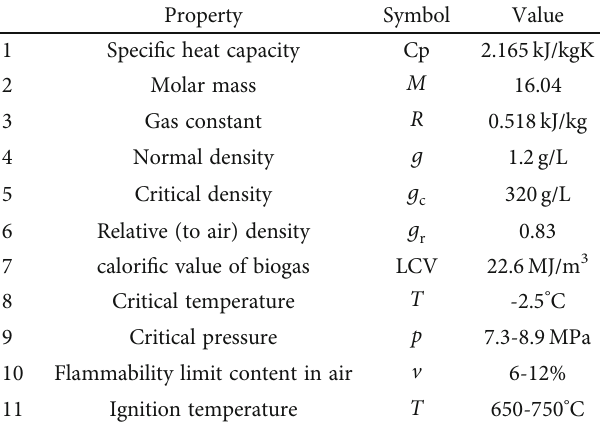
Table 6: Biogas properties [43, 75,